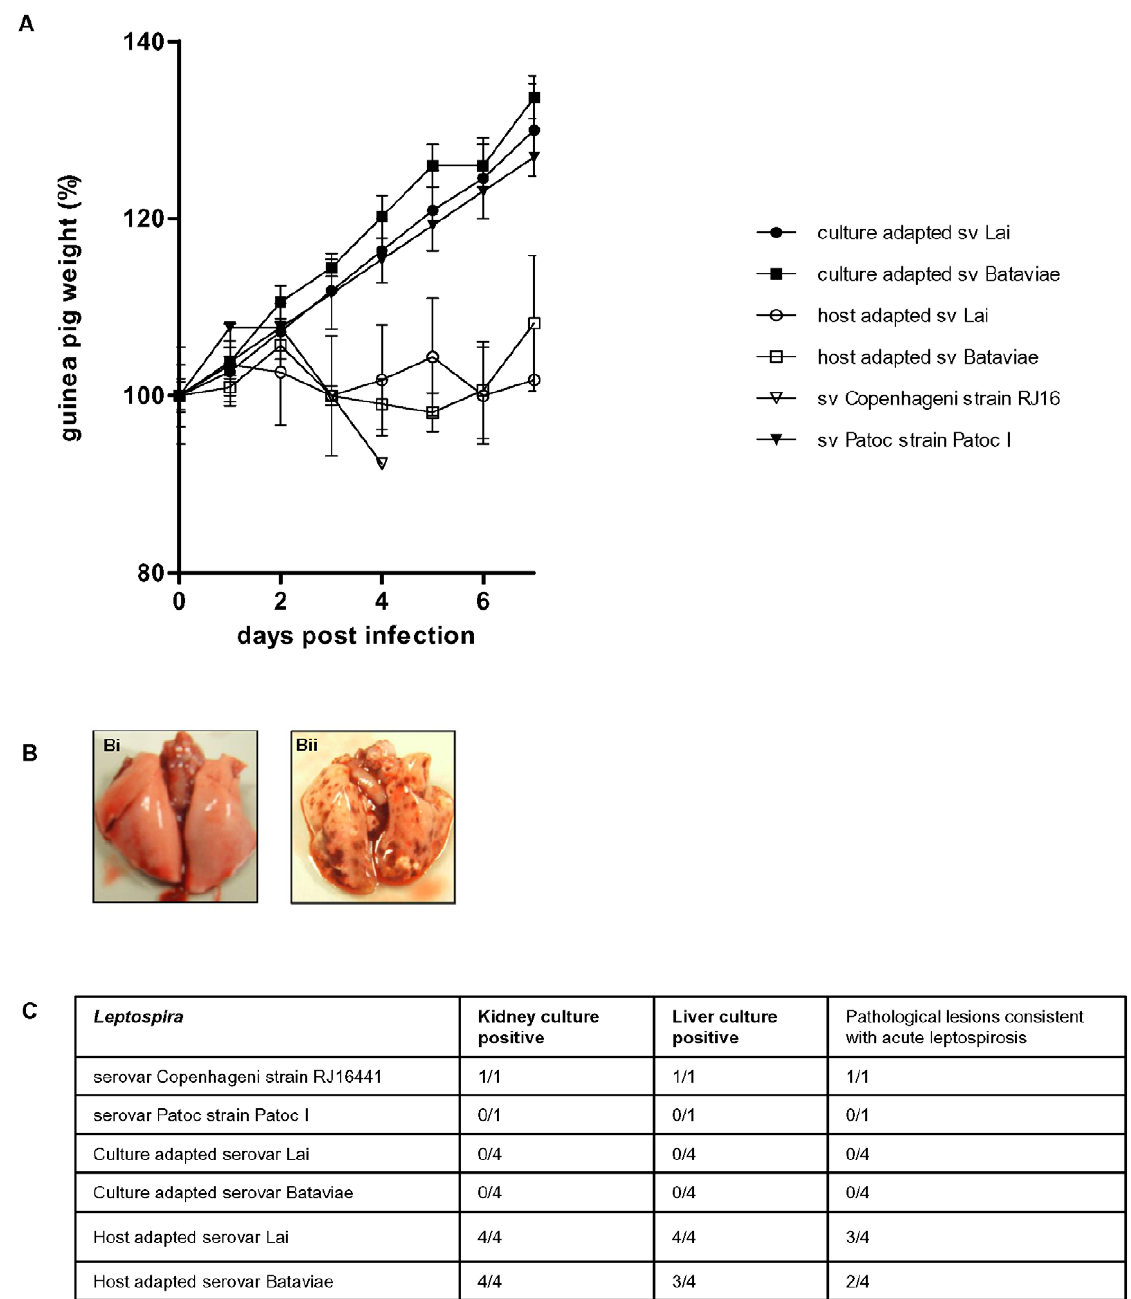
Figure 1. Virulence testing in guinea pigs. Hartley male guinea pigs (3 weeks of age) were injected intraperitoneally with 10 7 in vitro cultivated leptospires. All guinea pigs were between 250–330 g on the day of infection (day 0). Panel A. Record of guinea pig weights. Weight is represented as percentage of average weight on day 0. Weights were recorded daily until euthanasia. Panel B. Lung gross pathology following infection with leptospires. (Bi) Typical example of culture-adapted serovar Bataviae and Lai, in guinea pig failing to induce pathology, (Bii) Typical example of host- adapted serovar Bataviae and Lai in moribund guinea pigs, showing diffuse pulmonary hemorrhages. Panel C. Culture results of kidney and liver tissue and pathology from guinea pigs post mortem . Pathology is considered consistent with acute leptospirosis when progressive weight loss, profound pathology, jaundice and pulmonary haemorrhage are observed.